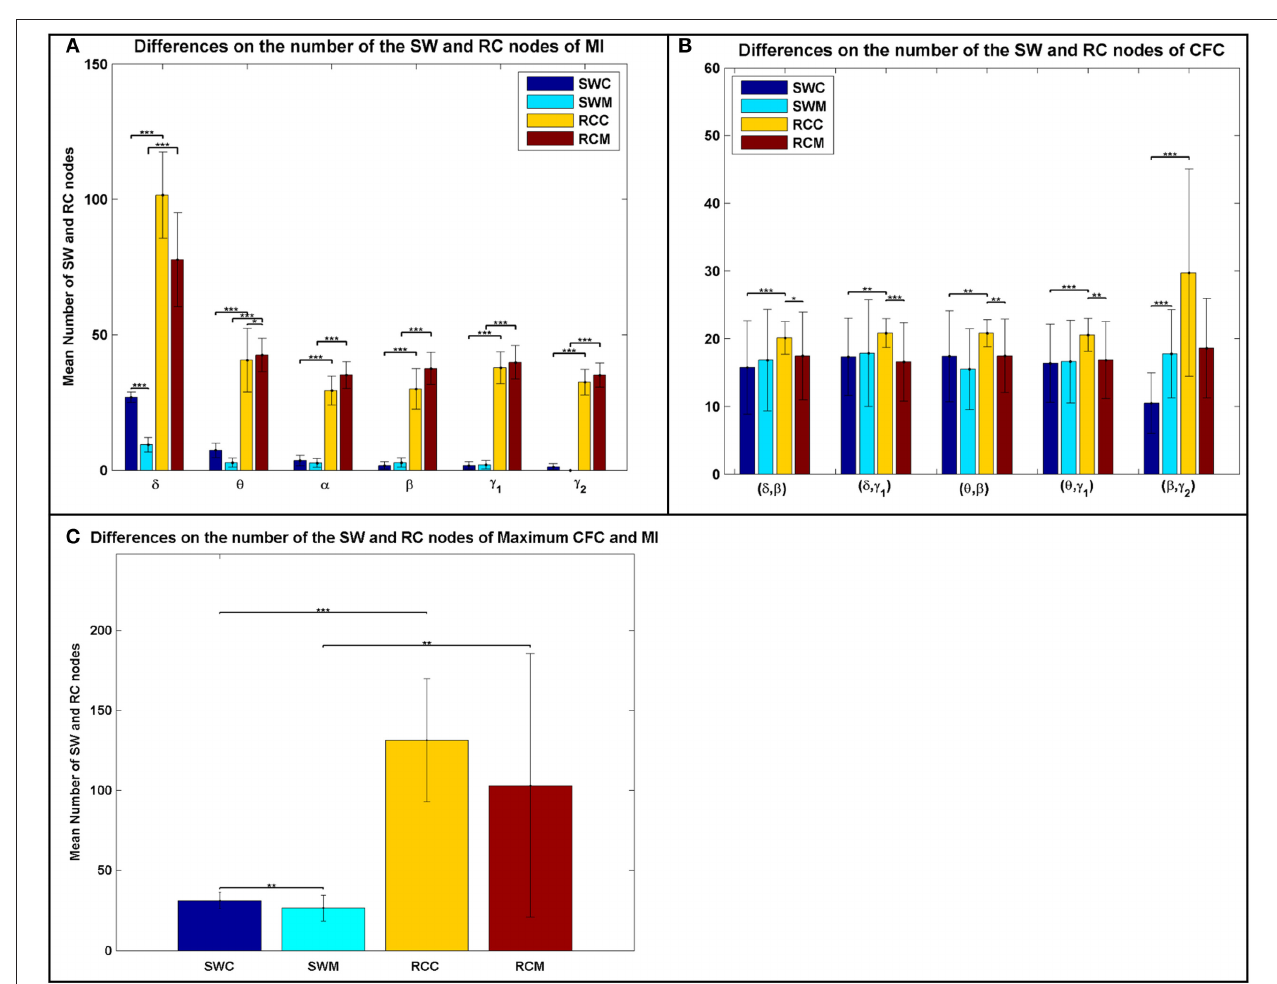
FIGURE 3 | Average number of SW and RC nodes for (A) IFCG; (B) CFCG, and (C) ICFCG. Statistical comparisons between SW and RC nodes for each group (SWC: SW Control, RCC: RC Control, SWM: SW mTBI, and RCM: RC mTBI) and between groups for each network organization (SWC vs. SWM and RCC vs. RCM). All comparisons (paired test linked by *) reach statistical significance ( p -value: * < 0.05; ** < 0.01, and *** <